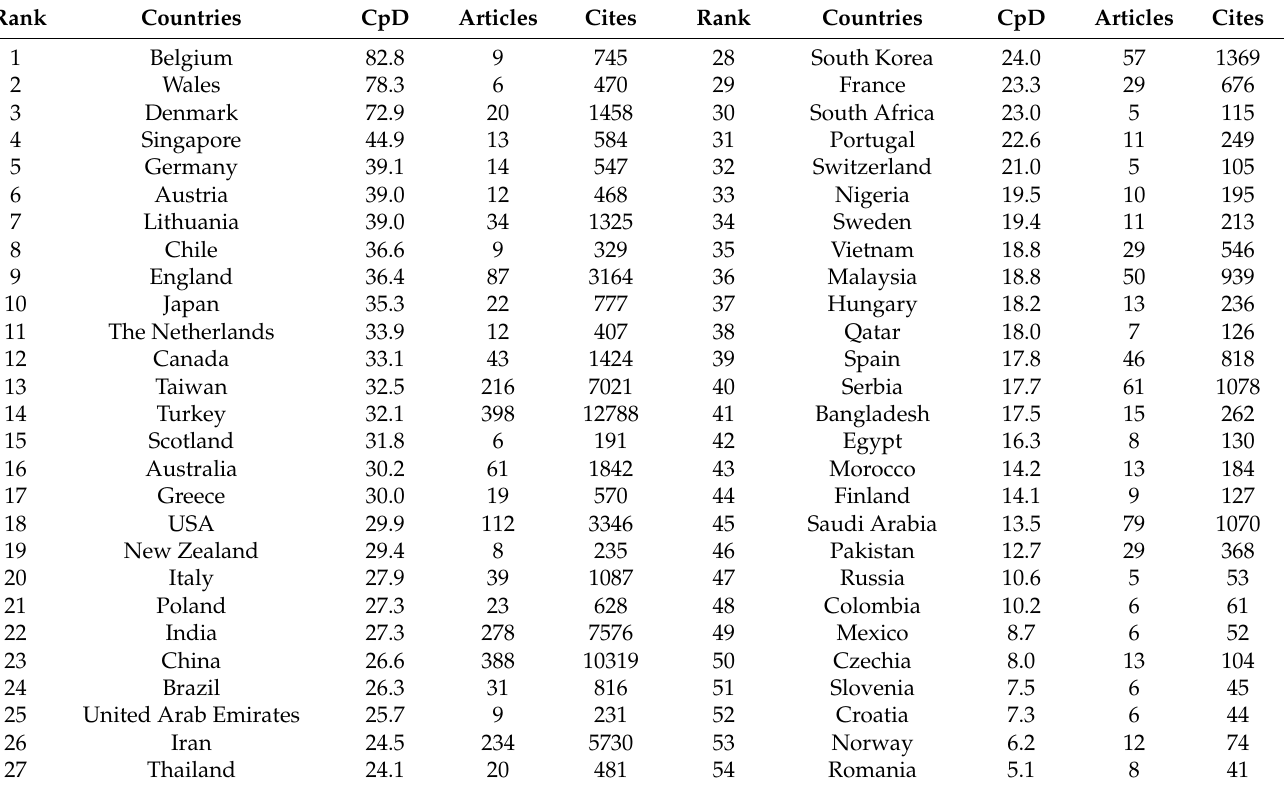
Table 6. Ranking of countries sorted by CpD. Countries with five or more published